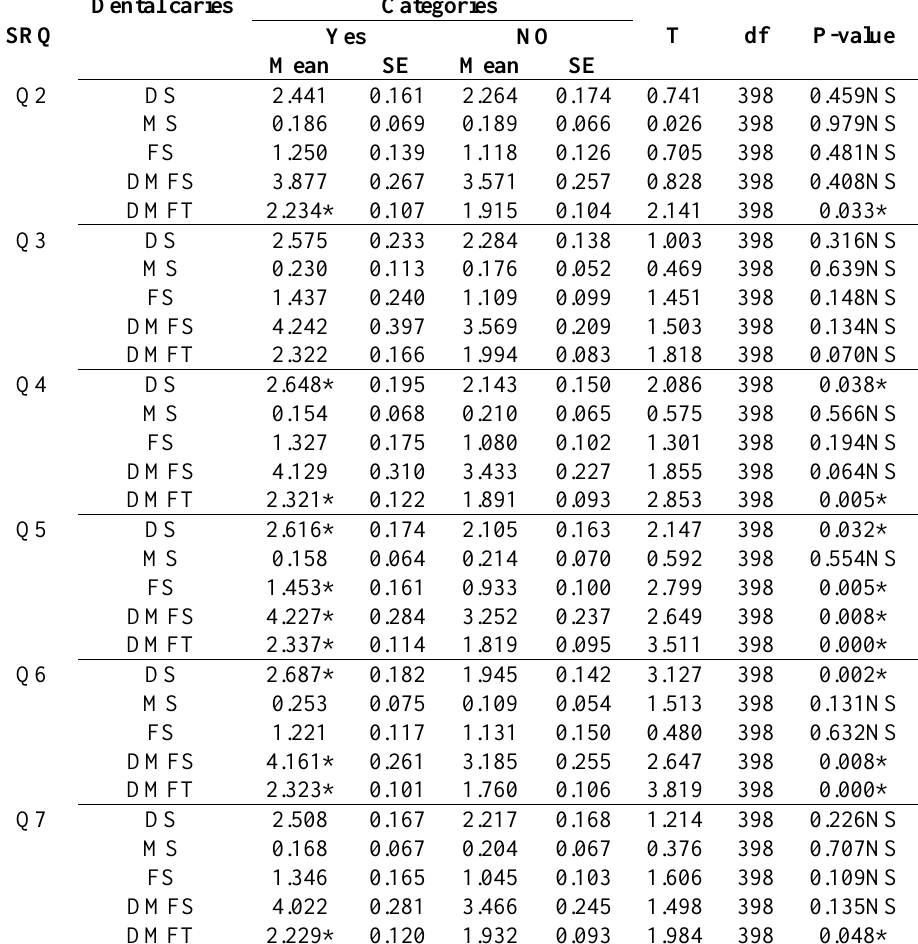
Table (5) ׃ Descriptive and statistical test of caries experience among questionnaire. Dental SRQ